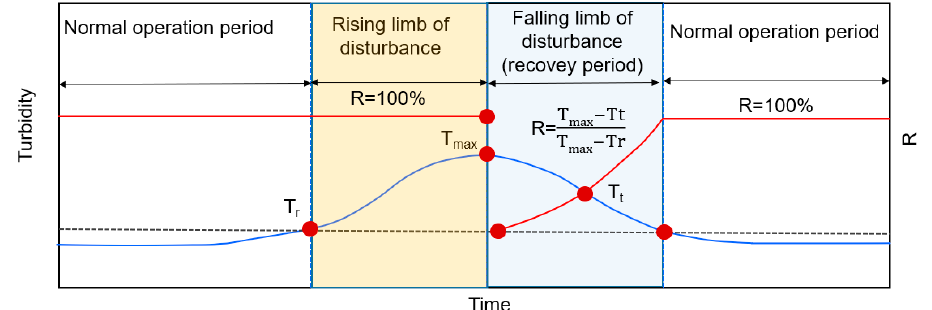
Figure 2. Schematic of the recovery rate in a water treatment process.